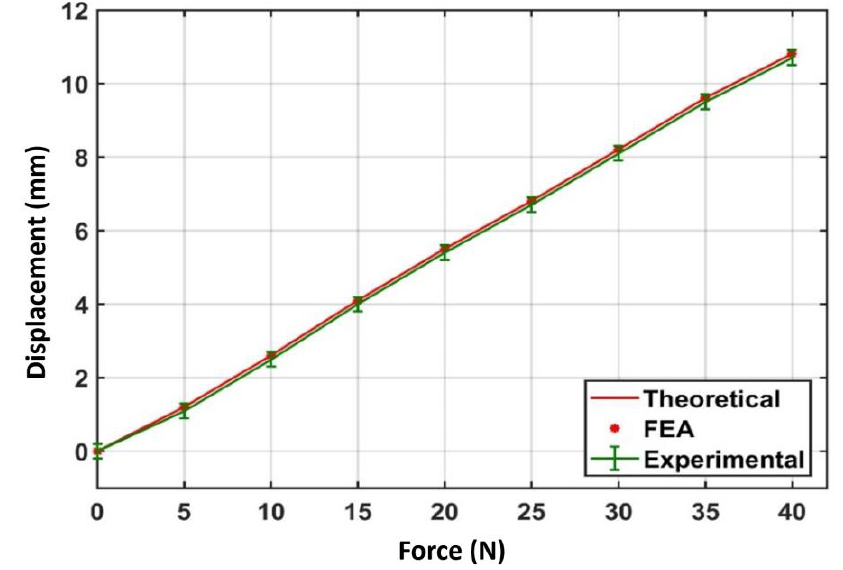
Figure 12. Comparison of theoretical, finite element analysis (FEA) and experimental force deflection characteristics.